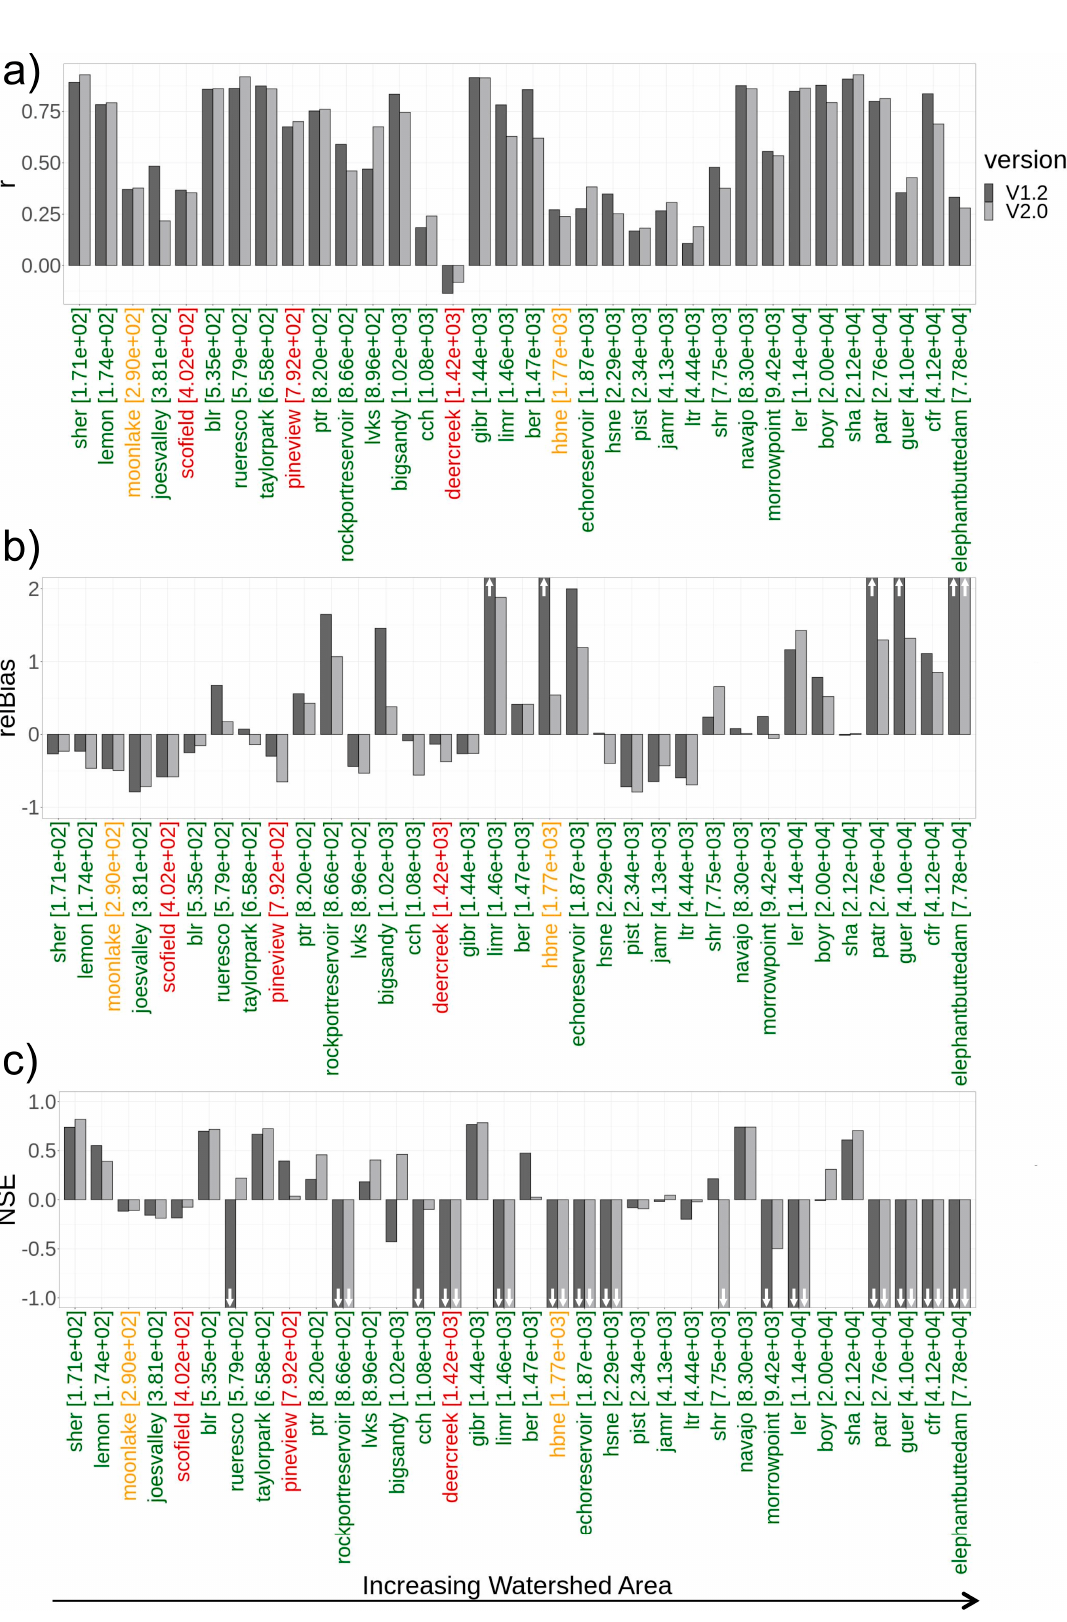
Figure A2. Goodness of fit scores from the NWM v1.2 (dark grey) and NWM v2.0 (light grey) retrospective total inflow evaluation, ordered by increasing watershed area. From top to bottom: r ( a ) , relBias ( b ) , NSE ( c ) .